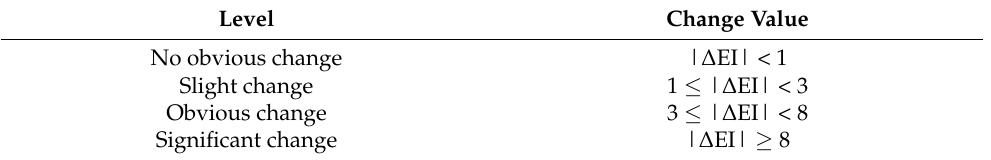
Table 7. Classification of changes in ecological environment.